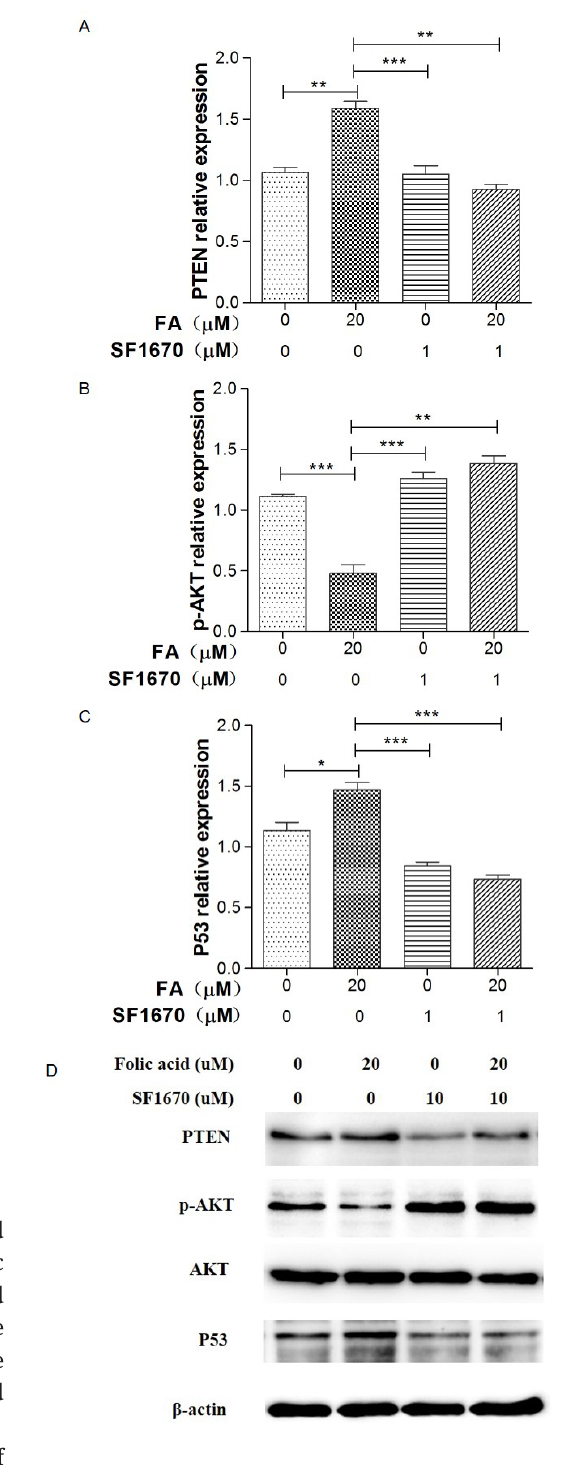
Figure 4: SF1670 inhibits the up-regulated expression of PTEN and P53, and down-regulated expression of p-AKT by folic acid in MDA- MB-231 cells. After pretreatment of MDA-MB-231 cells with 1 μM SF1670 for 2 h, 20 μM folic acid was added to the culture medium for 24 h. The protein expression levels of PTEN, p-AKT, AKT and P53 were detected by Western blot, and β-Actin was used as an internal control.